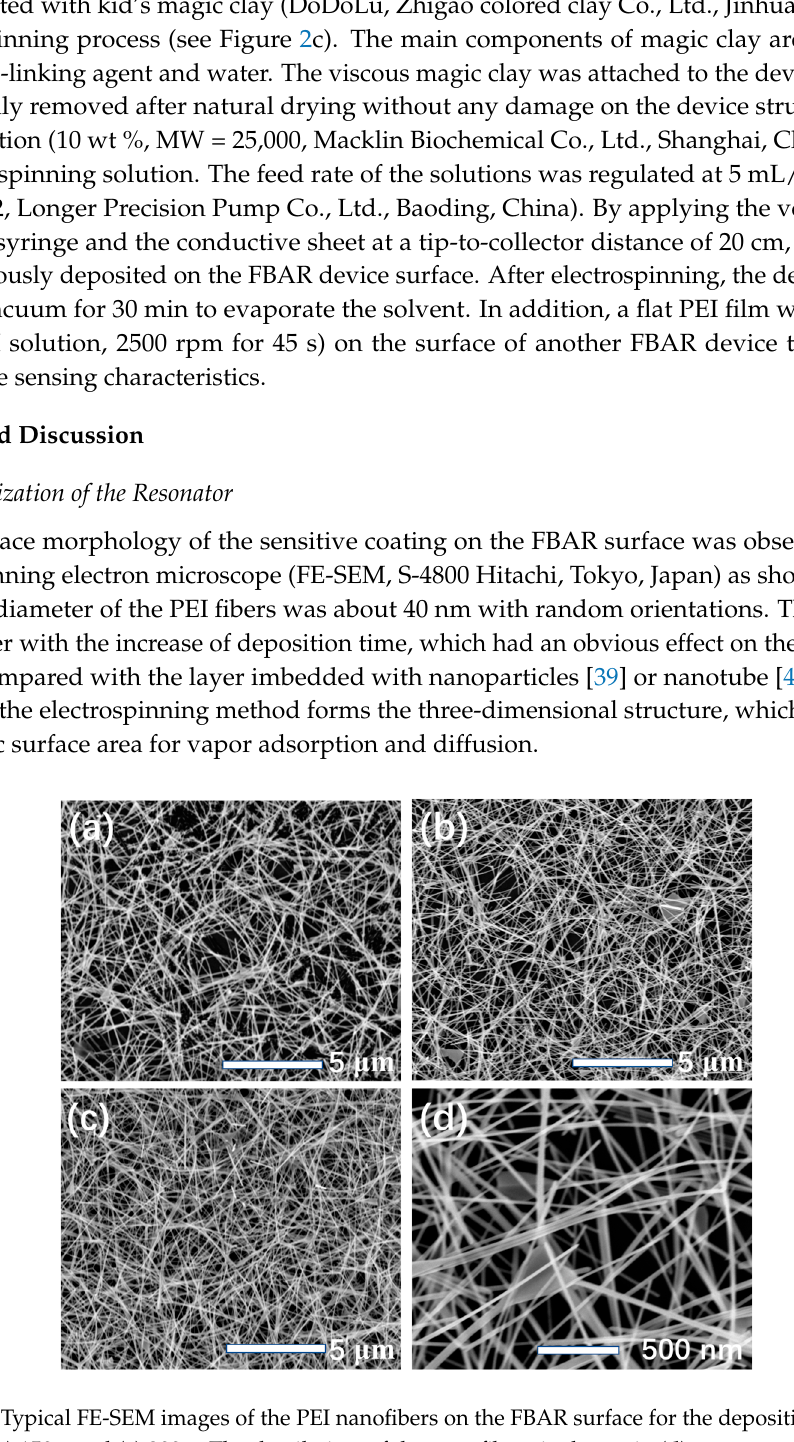
Figure 3. Typical FE-SEM images of the PEI nanofibers on the FBAR surface for the deposition times of ( a ) 50 s, ( b ) 150 s and ( c ) 300 s. The detail view of the nanofibers is shown in ( d ).